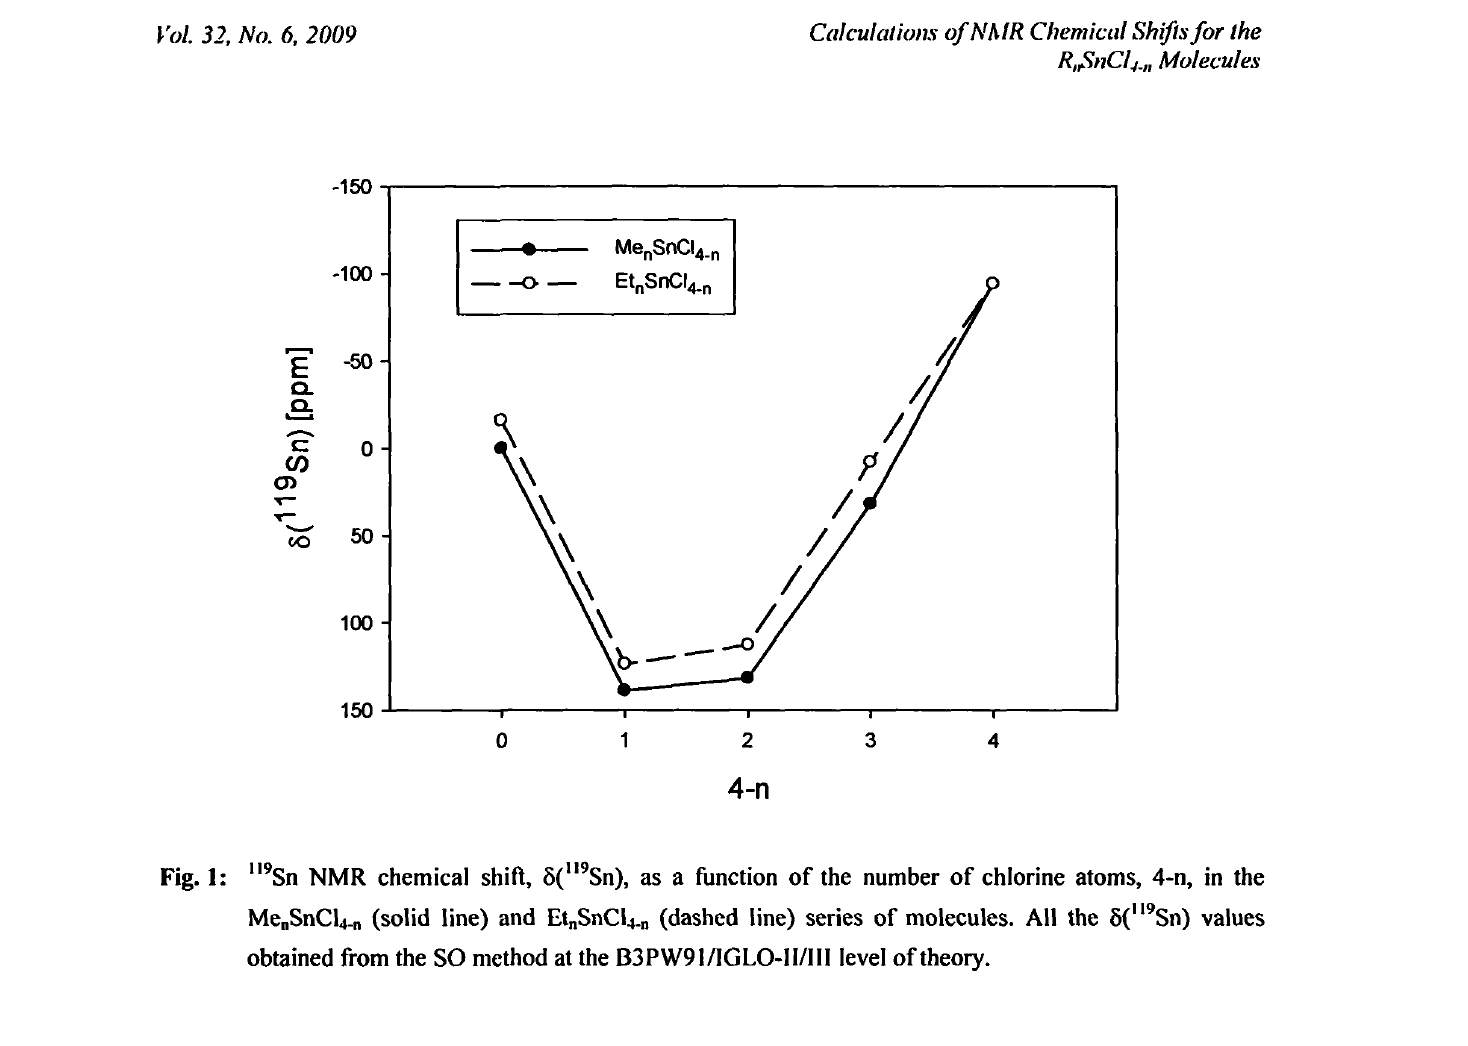
SnCl . (dashed line) series of molecules. All the δ(" 19 Sn) n 4 n